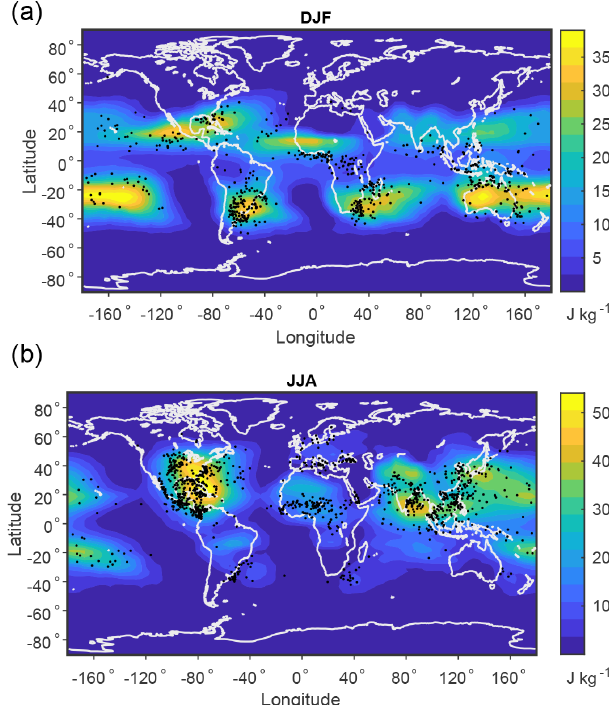
Figure 5. Nonconvective local MAPE (color shading) and Eady growth rate averaged in the vertical over 500–750hPa (black con- tours of 0.5 and 0.7d − 1 ) based on the climatological mean over 1979–2018 in (a) DJF and (b) JJA.